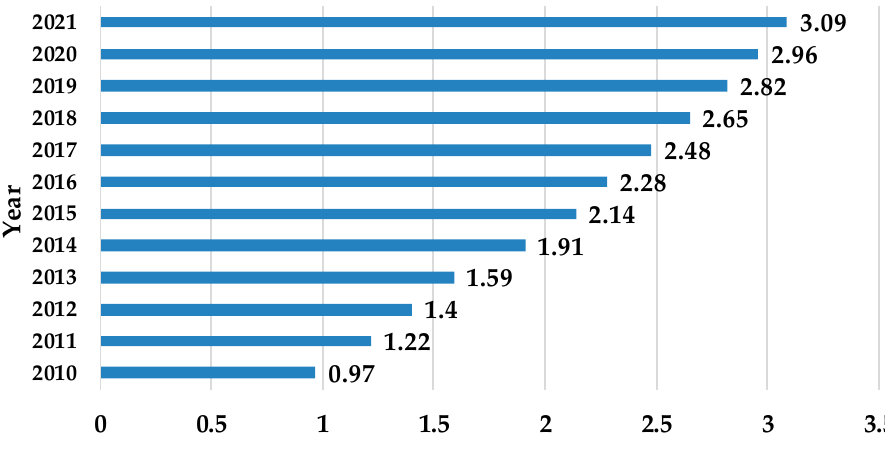
Figure 1. Annual number of global social network users (billion) 2010–2021 [1].